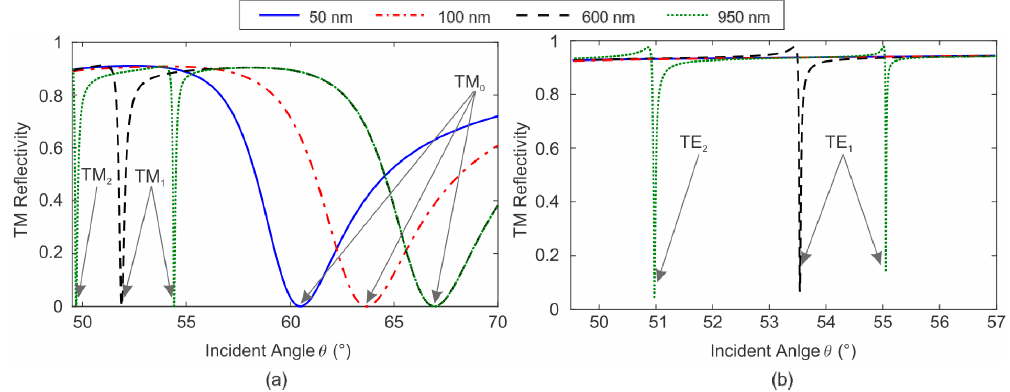
Figure 5. Reflectivity curves R( θ ) at the wavelength of 633 nm with increasing values of h SiO2 for both ( a ) TM and ( b ) TE polarizations. The arrows highlight the resonant wave mode for each minimum in R . The thickness of the gold thin film is h Au = 46 nm and the external medium is water.